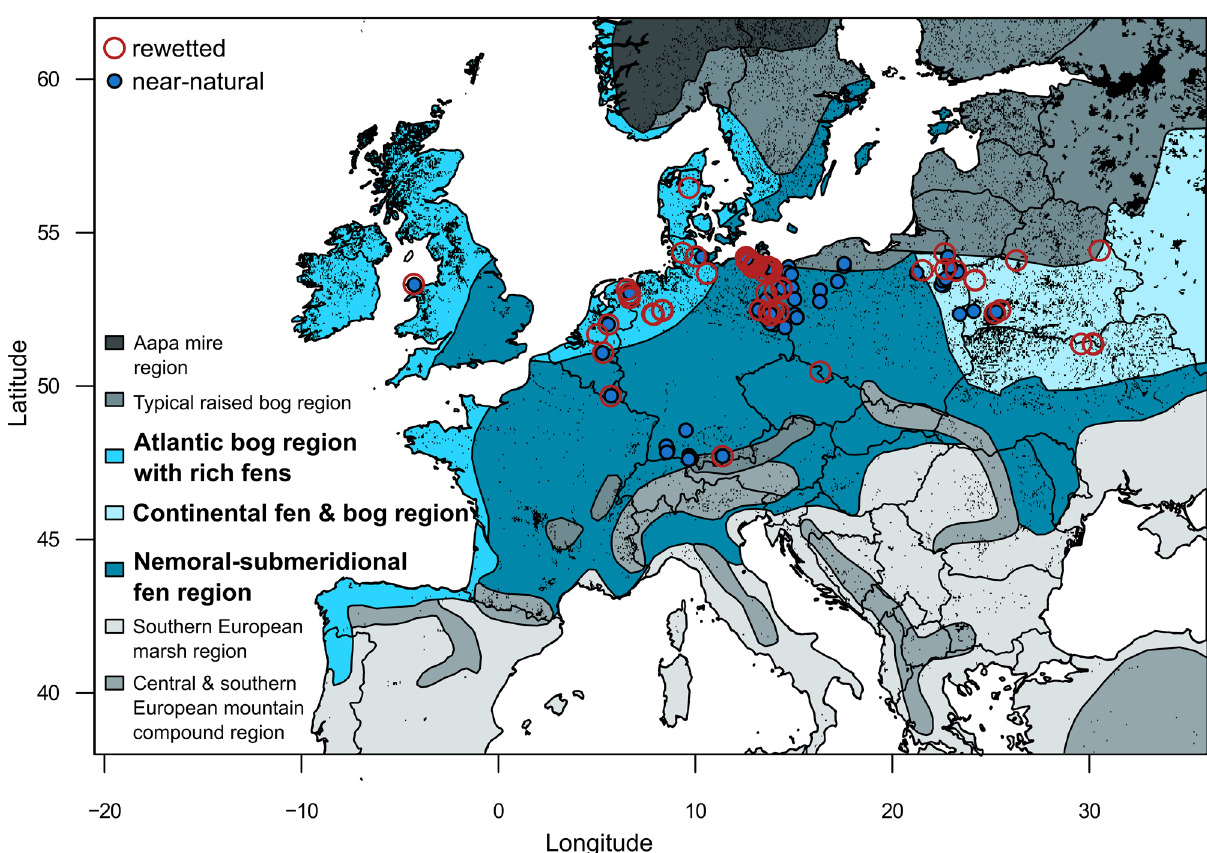
Fig. 1 Map of the study sites contrasting rewetted sites (open red symbols) and near-natural sites ( fi lled blue). We studied temperate fen peatlands, which occur mainly in the mire regions according to Joosten et al. 10 depicted in shades of blue and set off in bold in the legend. Peatland occurrence according to the Peatland Map of Europe 53 is shown in